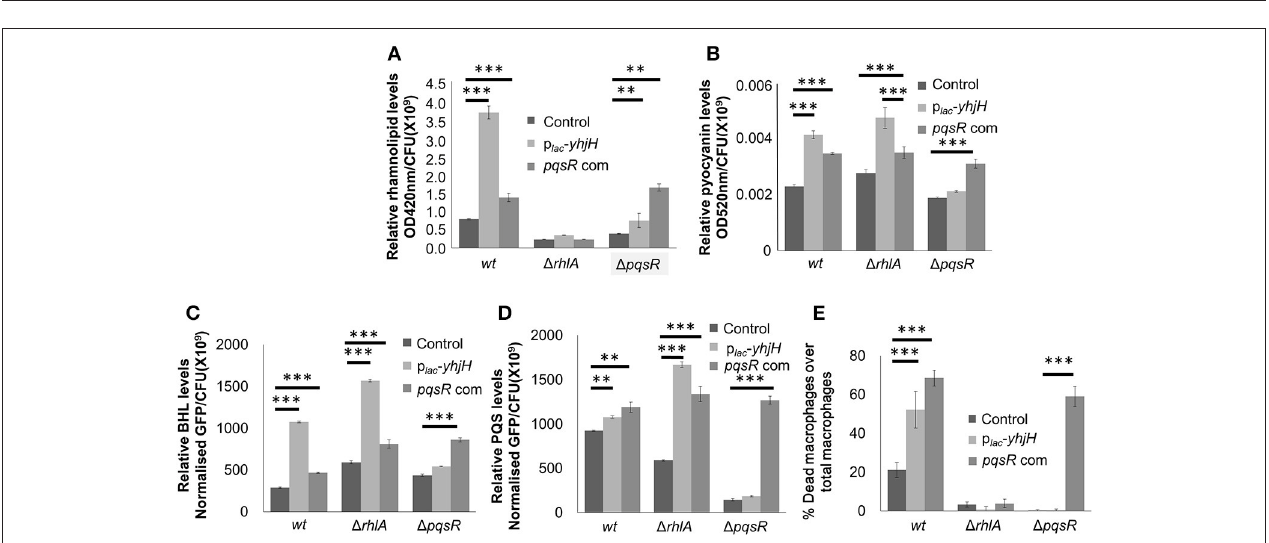
FIGURE 4 | PqsR links c-di-GMP signaling to rhl quorum sensing. Rhamnolipid (A) , pyocyanin (B), BHL (C) and PQS (D) quantification of P. aeruginosa wt and 1 pqsR cultures. (E) Cytotoxicity of P.aeruginosa /p lac -yhjH and 1 pqsR against macrophages. Means and s.d. from triplicate experiments are shown. ** P < 0.01, *** P < 0.001, One-way